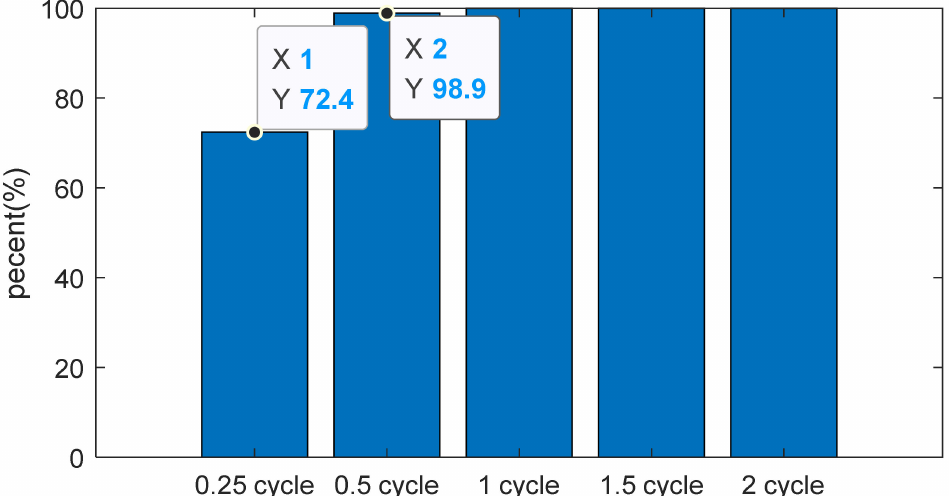
Figure 18. Model accuracy for open conductor fault type classification by input